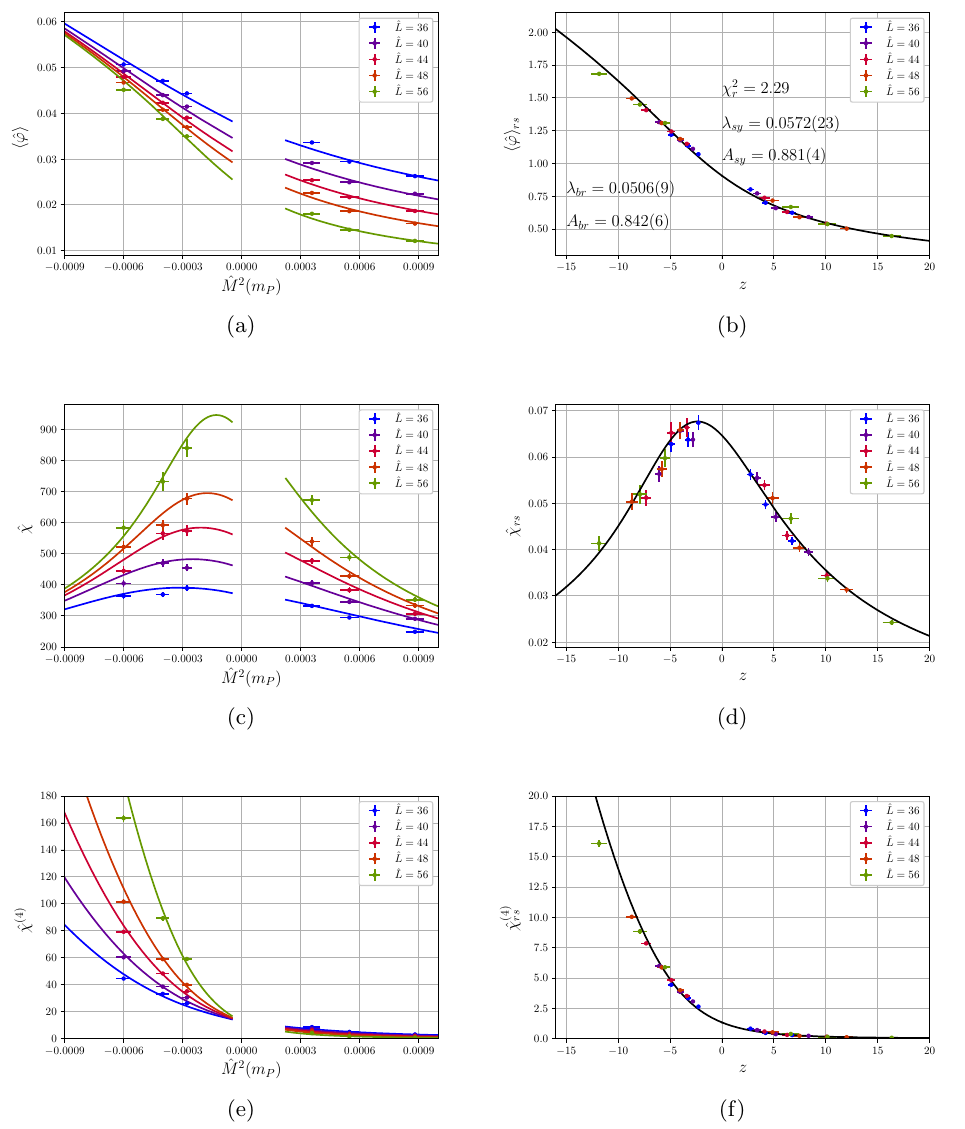
Figure 5 . Result of the scaling test via (cid:12)tting and (3.7) are displayed in (a), (c) and (e). The corresponding rescaled quantities de(cid:12)ned in eqs. (3.19), (3.20) and (3.21) are plotted against the scaling variable in (b), (d) and (f).